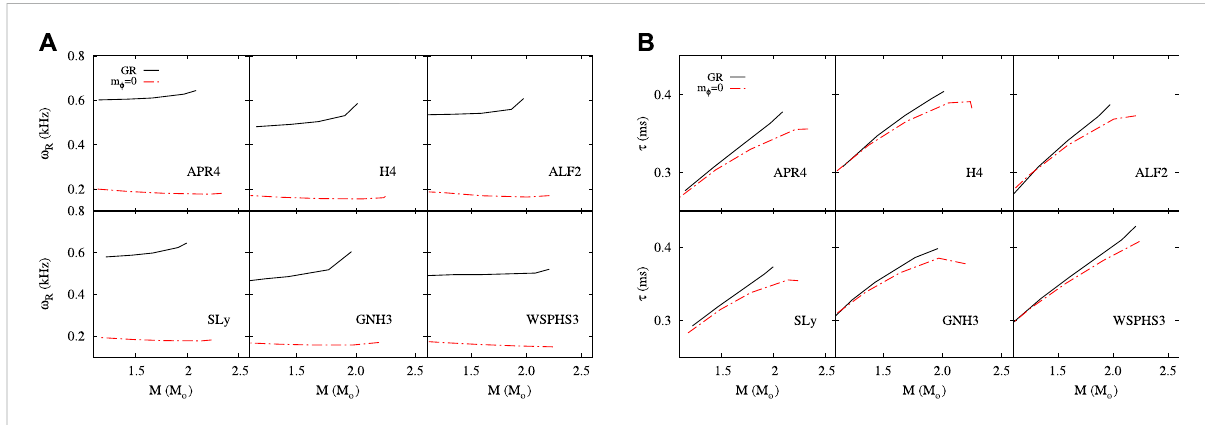
FIGURE 1 Frequency ω R inkHz (A) anddampingtime τ inmilliseconds (B) versus theneutronstar mass M in M ⊙ for thequadrupole ϕ -mode.The sixpanels represent six equations of state, and the color red indicates the massless case, with the general relativistic case in